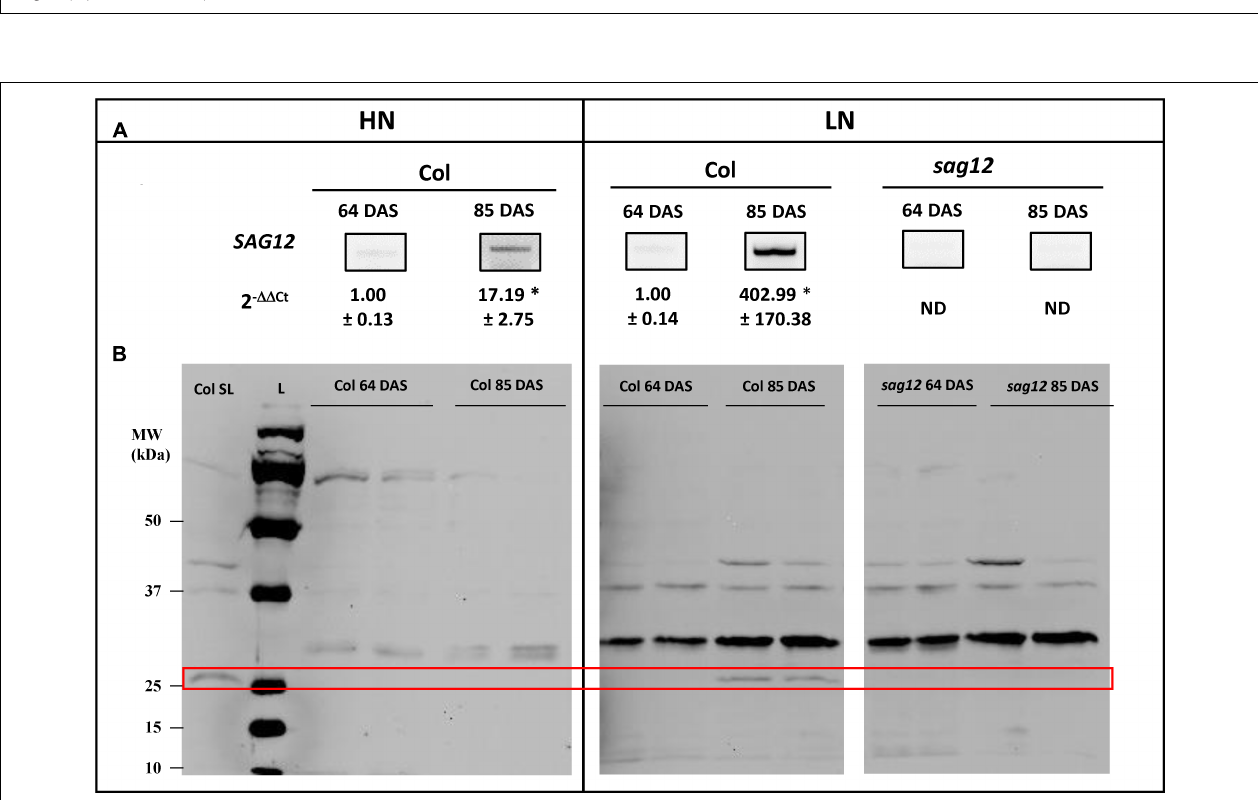
FIGURE 5 | SAG12 is expressed in roots at reproductive stage and especially under LN condition. (A) SAG12 gene expression was monitored using RT-PCR and quantified using RT-qPCR for each condition (HN and LN), the expression of the SAG12 gene at the reproductive stage (85 DAS) has been relativized with respect to the level of the SAG12 expression in Col for the corresponding N treatment at the vegetative stage. ND, not detected. For a given nitrogen condition (HN and LN), significant difference between Col at vegetative and reproductive stage ( ∗ p ≤ 0.05; n = 3). (B) Detection of SAG12 by Western blot using an anti-SAG12 specific polyclonal antibody provided by Agrisera R (cid:13) (AS142771). The red frame highlight the location of SAG12 protein. The mRNAs and soluble proteins were extracted from roots of Col and sag12 cultivated under HN or LN conditions and harvested at vegetative (64 DAS) and reproductive (85 DAS) stages. Soluble proteins extracted from senescing leaves of Col (Col LS) were used as positive control for SAG12 expression. The molecular weights (MW; kDa) of the Precision Plus Protein Dual color Standards ladder (Bio-Rad) were indicated.